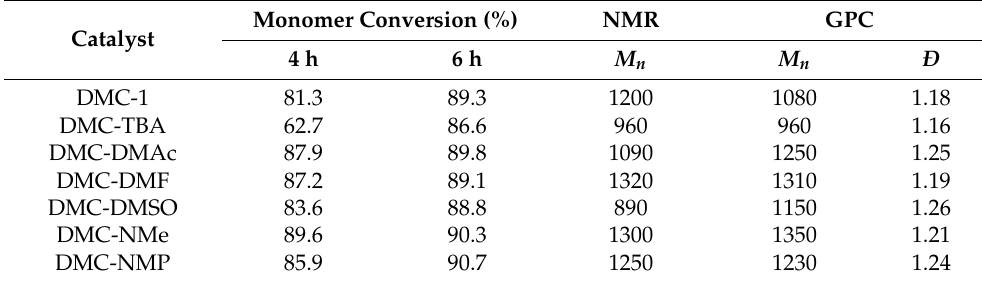
Table 5. Results of the ROP of VL using various DMC catalysts. Monomer Conversion Catalyst